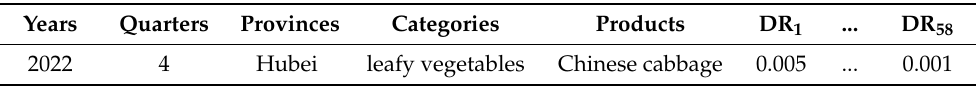
Table 1. Standard data